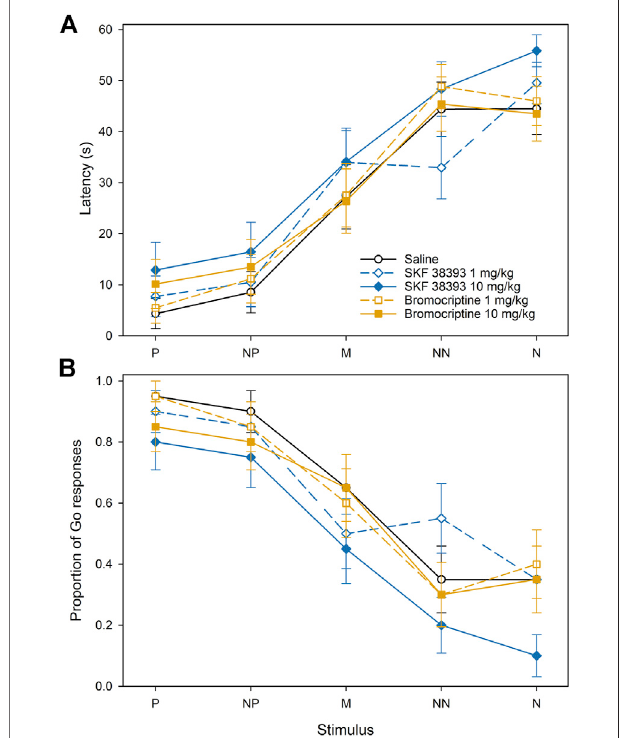
FIGURE 4 | The effect of dopamine D1 and D2 receptor agonists on the approachlatencies (A) andmeanproportionofGoresponses (B) ofJapanese quailhensinthespatialjudgmenttask.Mean±SEMoftheapproachlatencies to the positive (P), near-positive (NP), middle (M), near-negative (NN), and negative (N)